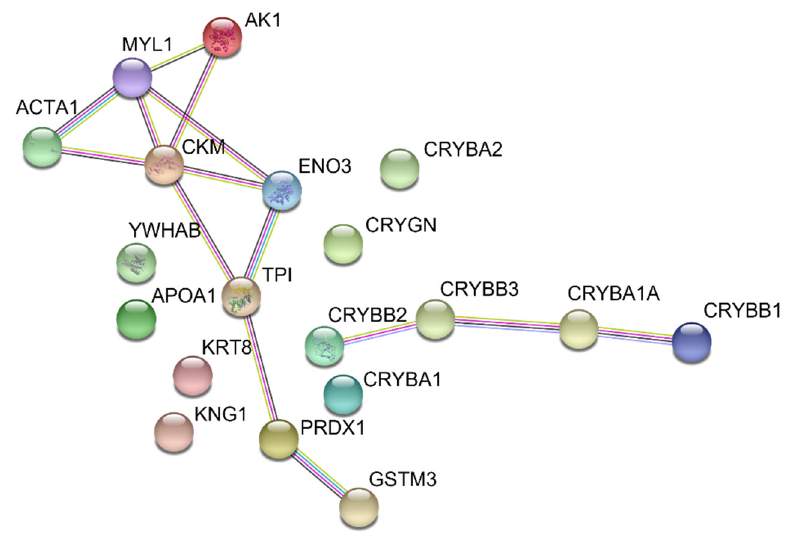
Figure 5. STRING protein–protein association network analysis of 19 identified differentially ex- pressed medaka proteins upon exposure to K. mikimotoi . Light blue and pink edges represent known interactions obtained from curated database and experiments, respectively, while yellow, black, and purple edges represent protein association by textmining, co-expression, and homology, respectively. Proteins starting with codes in parentheses represent muscle actin (ACT), myosin light chain (MYL), adenylate kinase (AK), creatine kinase (CK), enolase (ENO), triosephosphate isomerase (TPI), peroxiredoxin (PRDX), glutathione S-transferase (GST), 14-3-3 protein (YWHA), apolipoprotein (APO), keratin (KRT), kininogen (KNG), and crystallin (CRY).